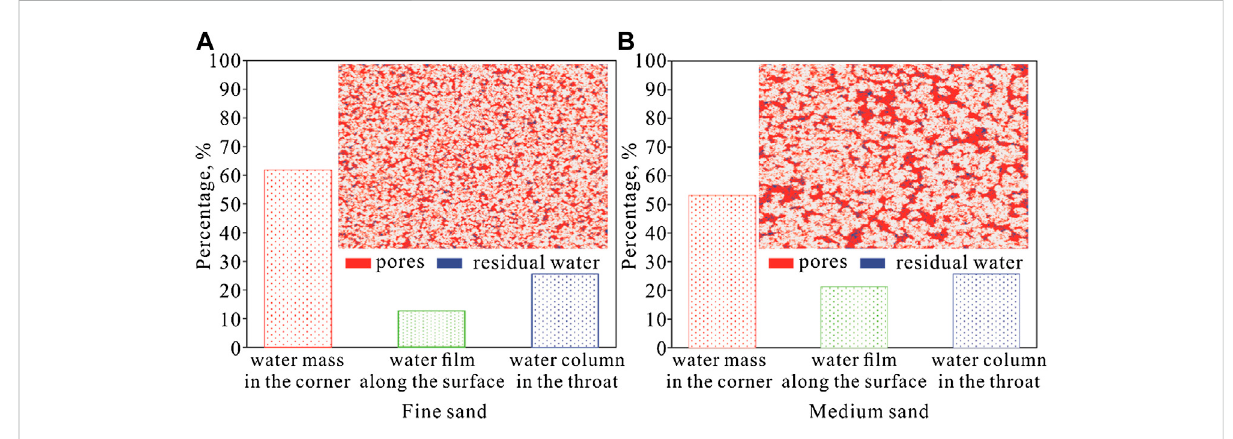
FIGURE 13 Thepercentageofvariousresidualwaterinsandstonesofdifferentgrainsizes (A) showsthepercentageofvariousresidualwaterin fi nesand; (B) shows the percentage of various residual water in medium sand.